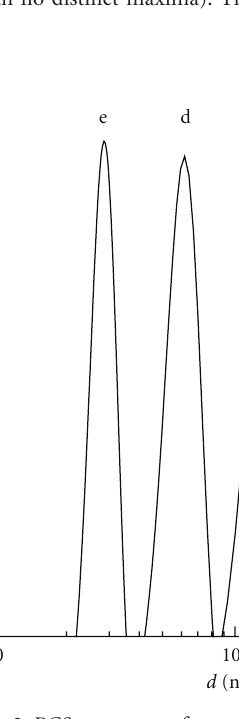
Figure 2: PCS spectrum of samples PMMA (a), BPM1 (b), BPM3 (c), BPM7 (d), and BP44 latex